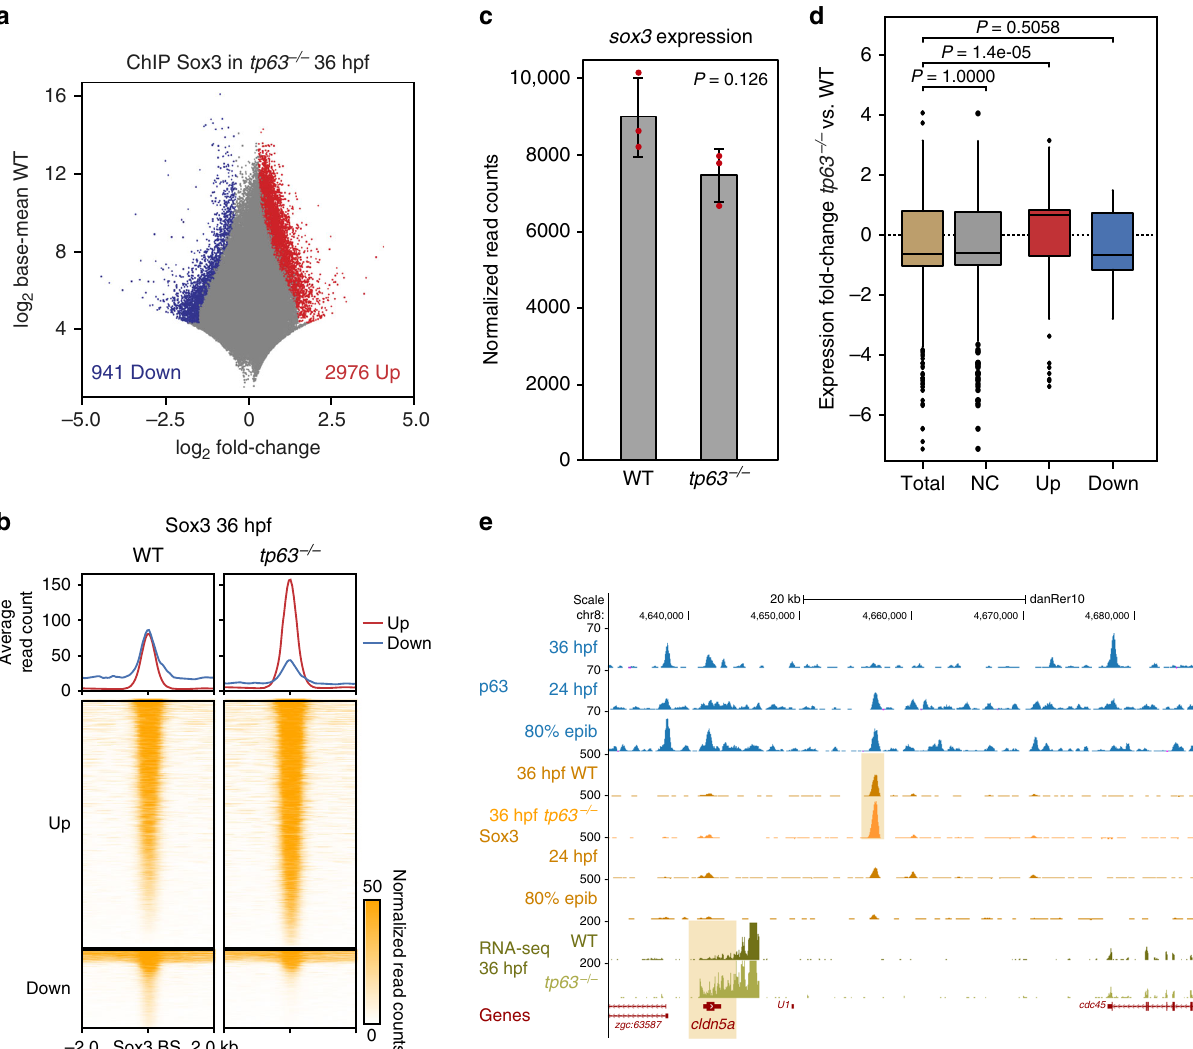
Fig. 4 p63 regulates Sox3 binding to neural enhancers and the neural program. a Differential analysis of Sox3 binding between WT and tp63 − / − at 36 hpf, calculated in a set of 147,588 Sox3 BSs (FDR < 0.05) from ChIPmentation ( n = 2 biological replicates per condition). The log 2 base mean Sox3 binding levels in the WT versus the log 2 fold-change of expression are plotted. Peaks showing a statistically signi fi cant differential expression ( p < 0.01) are highlighted in blue (downregulated) or red (upregulated). b Heatmaps and average pro fi les of the Sox3 BSs at 36 hpf from ( a ) in WT and tp63 − / − embryos. Peaks were separated according to the differential analysis in up-regulated (Up; n = 2,976) or down-regulated (Down; n = 941) in tp63 − / − mutant compared to WT. c Bar plot with the mean expression of sox3 gene in WT vs. tp63 − / − embryos at 36 hpf as measured by RNA-seq ( n = 3, for each condition). Error bars represent s.d. Individual values are shown as red dots. Non-corrected p -value from the differential expression analysis is shown. d Box plots showing the expression fold-change in tp63 − / − embryos of the transcripts associated to Up- ( n = 222), Down-regulated ( n = 75) and not changed (NC; n = 1,255) Sox3 BSs from ( a ) compared to the total de-regulated transcripts ( n = 2,344) in that mutant. Center line, median; box limits, upper and lower quartiles; whiskers, 1.5× interquartile range; points, outliers. Statistical signi fi cance was assessed using the Wilcoxon ’ s rank sum test. For ( c ) and ( d ), source data are provided as a Source Data fi le. e Genome tracks of p63 ChIP-seq, Sox3 ChIP-seq, and RNA-seq in the indicated developmental stages showing signal intensities in a region of chromosome 8. An up-regulated Sox3 BS in tp63 − / − mutant and the associated up-regulated gene ( cldn5a ) are highlighted in light orange. The Genes track represents ENSEMBL annotated genes. See also Supplementary Fig.